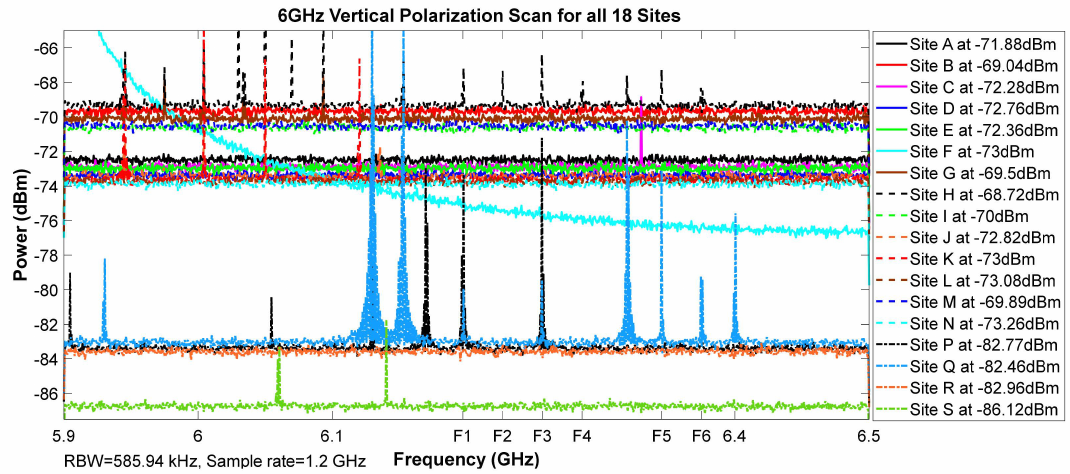
Figure 6. 6 GHz vertical polarization scan for all 18 sites.